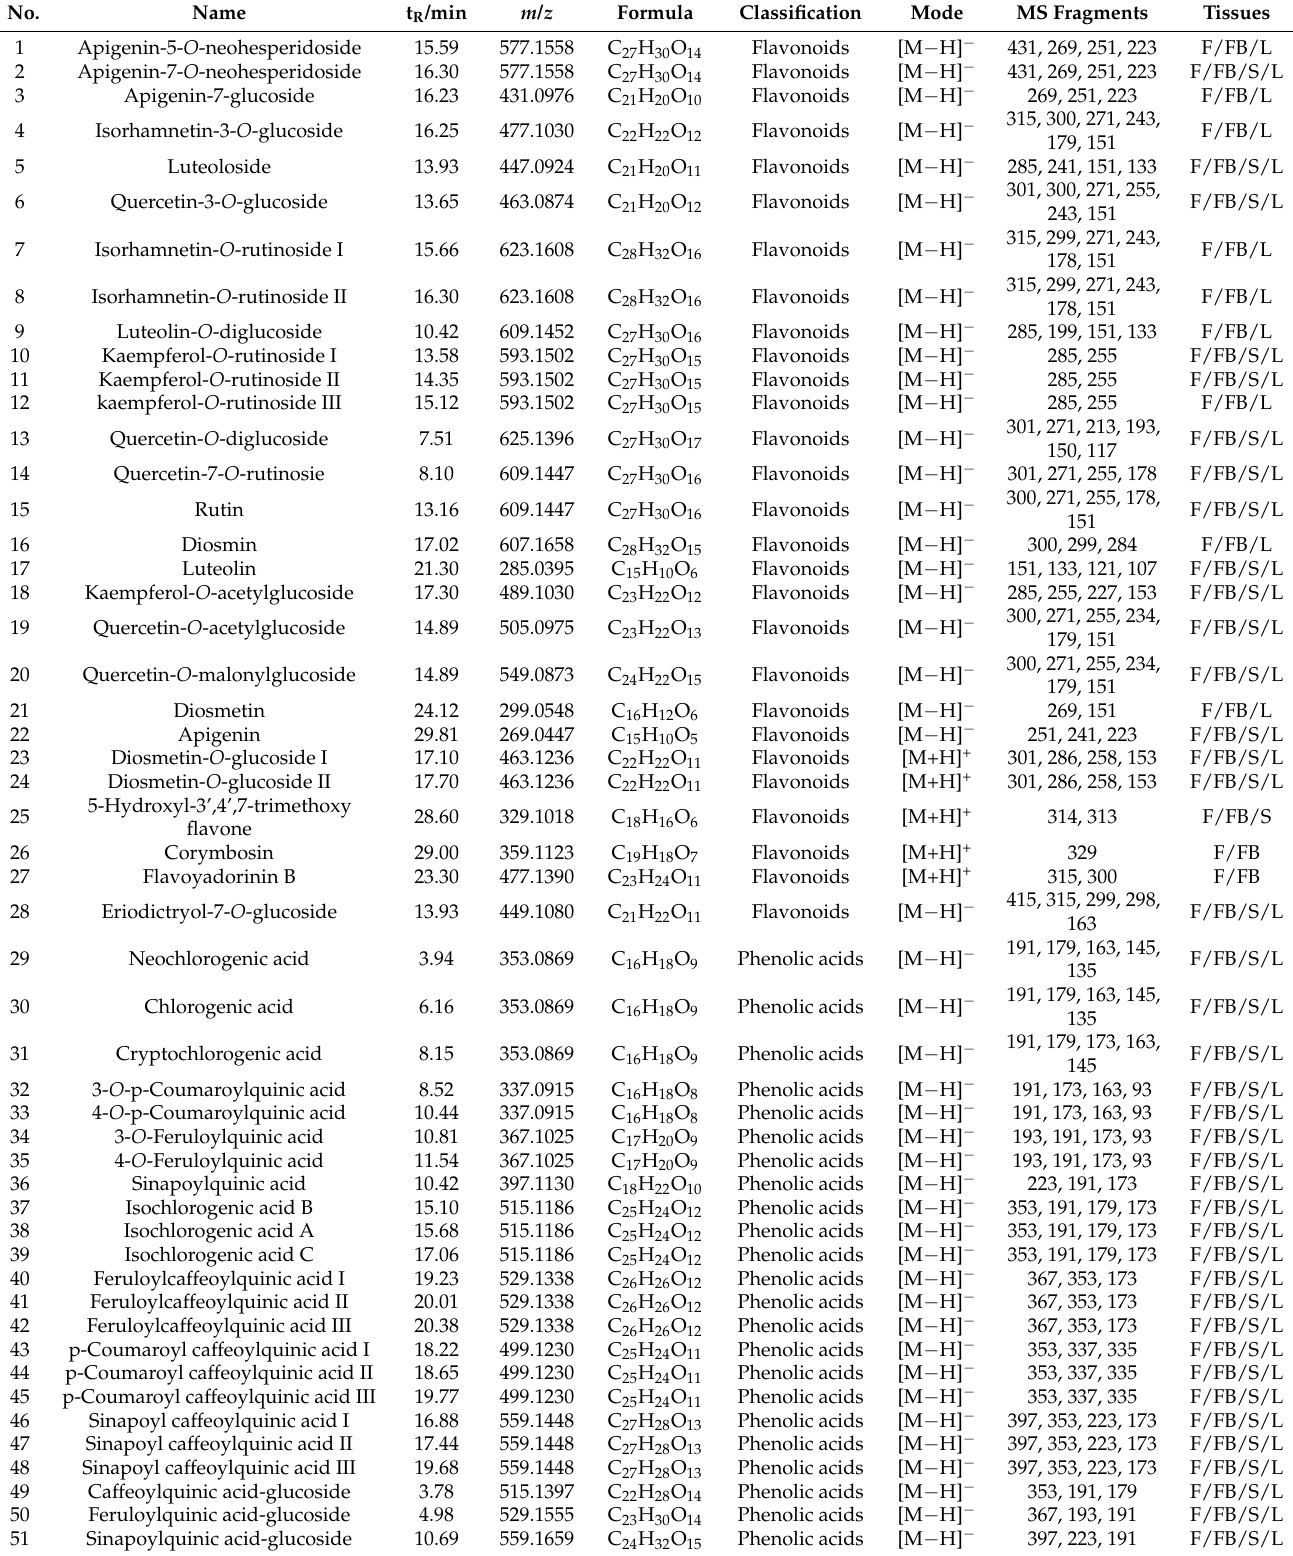
(Tables 1 and S1). Among them, secondary metabolites of phenolic acids, flavonoids and iridoids have specific fragment rules. Table 1. Identification of secondary metabolites in different tissues of